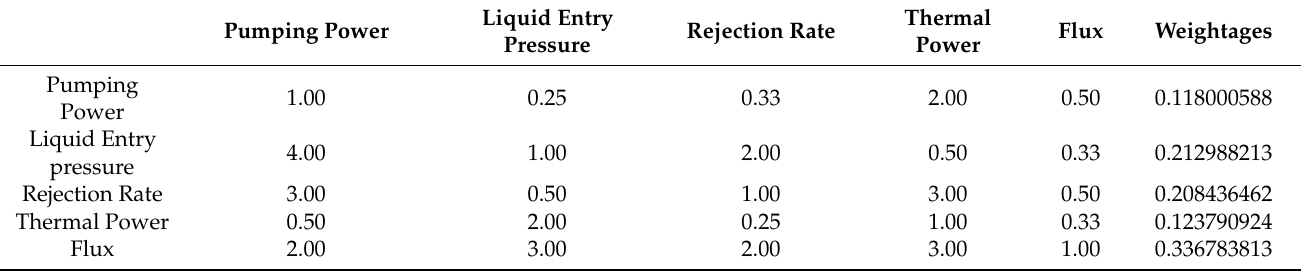
Table 4. Pairwise comparison of derivable outputs of MD using AHP-MDM by LDM3. Pumping